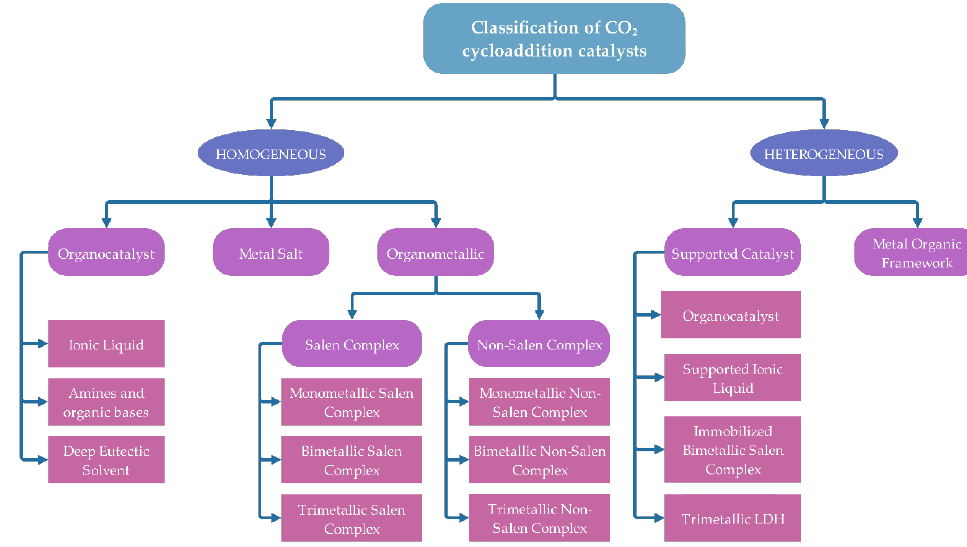
Figure 5. Classification of catalysts for cycloaddition of epoxide with CO 2 .